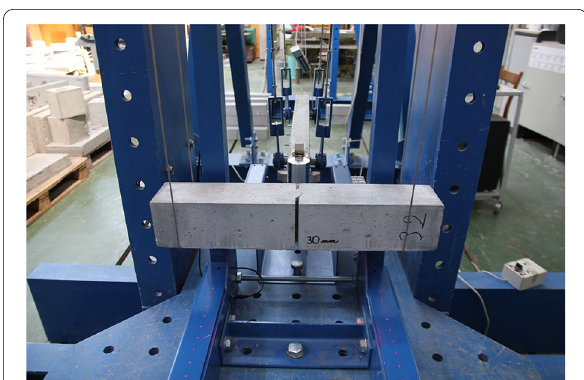
Fig. 4 The specimen resting in the loops formed by the steel